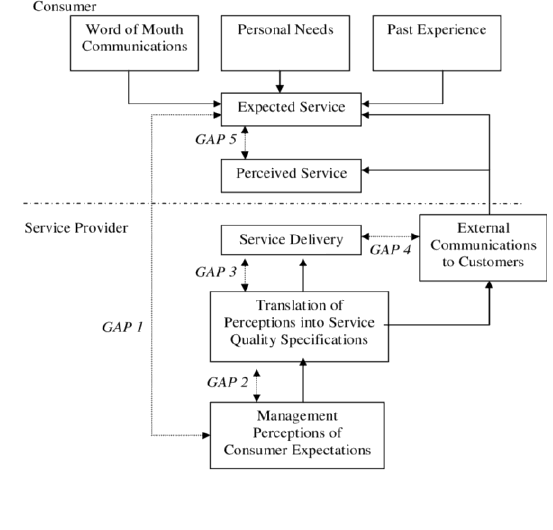
Figure 2. Conceptual Model of Service Quality Source: an adaptation from Parasuraman and Grewal